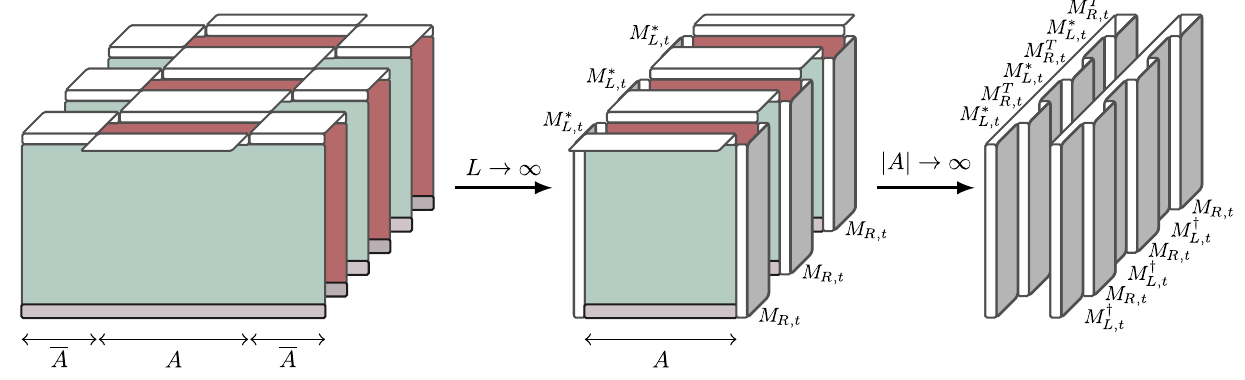
FIG. 2. Schematic illustration of tr ½ ρ 3 (cid:2) . Green and red rectangles are condensed representation of the green and red half of the time A evolution from Fig. 1. The white connections on the left represent trace over the rest of the system, while the connections on the right correspond to matrix products and then an overall trace. In the limit of large L − j A j the left and right parts of fixed points M (cid:3) and M connecting pairs of time sheets. Analogously, when the subsystem size becomes large, the section in the R;t L;t , and M T . Note the additional transpose of fixed points, which is the consequence of middle can be replaced with fixed points M † R;t L;t connecting the opposite parity of pairs of neighbors. Thus we obtain the rightmost diagram, which corresponds precisely to the rhs of Eq.